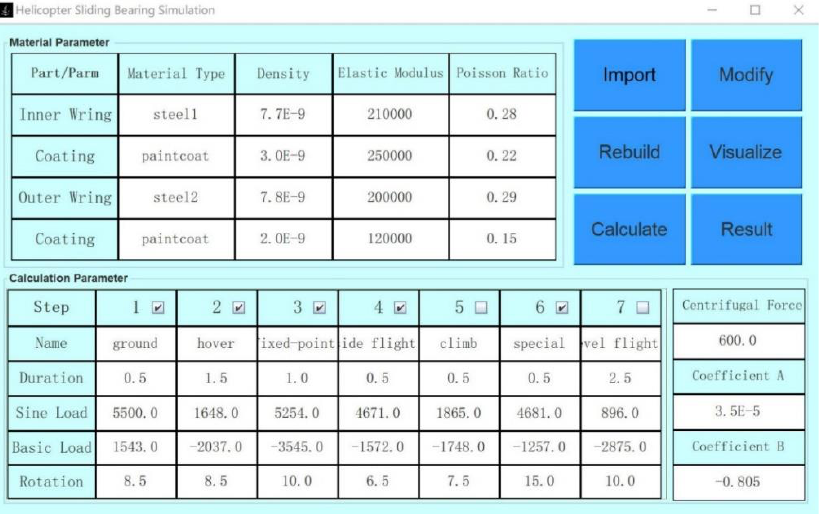
Figure 7. Tool from the helicopter sliding bearing simulation system based on the digital twin .